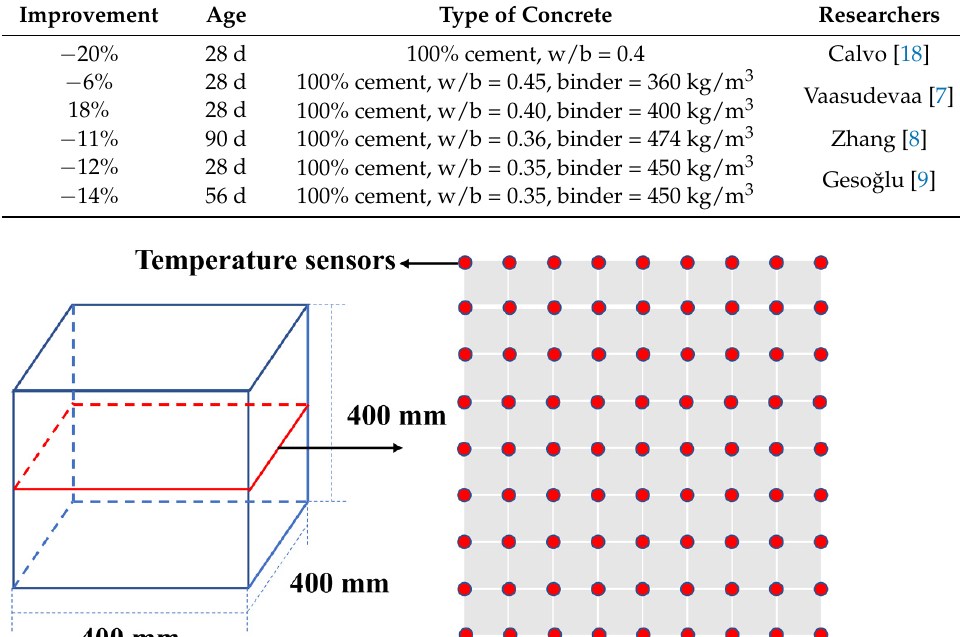
Figure 4. The heat damage of steam ‐ cured concrete [20]. The temperature stress of the concrete surface intensifies and causes damage with increasing steam curing temperature. The temperature stress promotes the coarsening of the porosity of the outer layer (mainly large pores with a diameter in the range from 0.5 to approximately 4 mm) and the generation of cracks in the interface transition zones [21]. The higher the temperature and the longer the curing time, the more obvious the reduc ‐ tion in the strength of concrete in the later stage [22]. However, the thermal damage from steam ‐ cured concrete is hardly reflected in nor ‐ mal testing, which is related to the size of the concrete specimen. The concrete used in the test is generally a 100 mm × 100 mm × 100 mm cube, its hydration heat is limited, and the surface temperature is not very high. Therefore, the early strength of steam ‐ cured concrete is greatly improved, but the later strength does not decrease in some tests [23]. The secondary hydration of mineral admixtures with low activity is often used to compensate for the pores to effectively reduce the effect of thermal damage on concrete. Meanwhile, the steam curing process is controlled to alleviate the problem of excessive pore coarsening on the concrete surface. (2) Shrinkage cracking: Slight volume deformation occurs in the normal curing pro ‐ cess of concrete. The degree of change in the volume of concrete is correspondingly